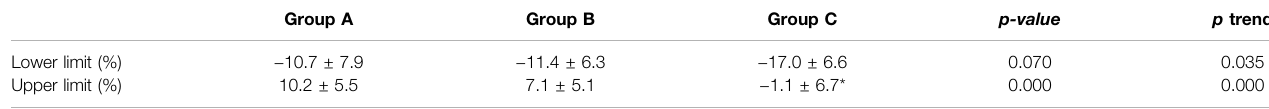
TABLE 2 | Oscillating range of blood glucose.